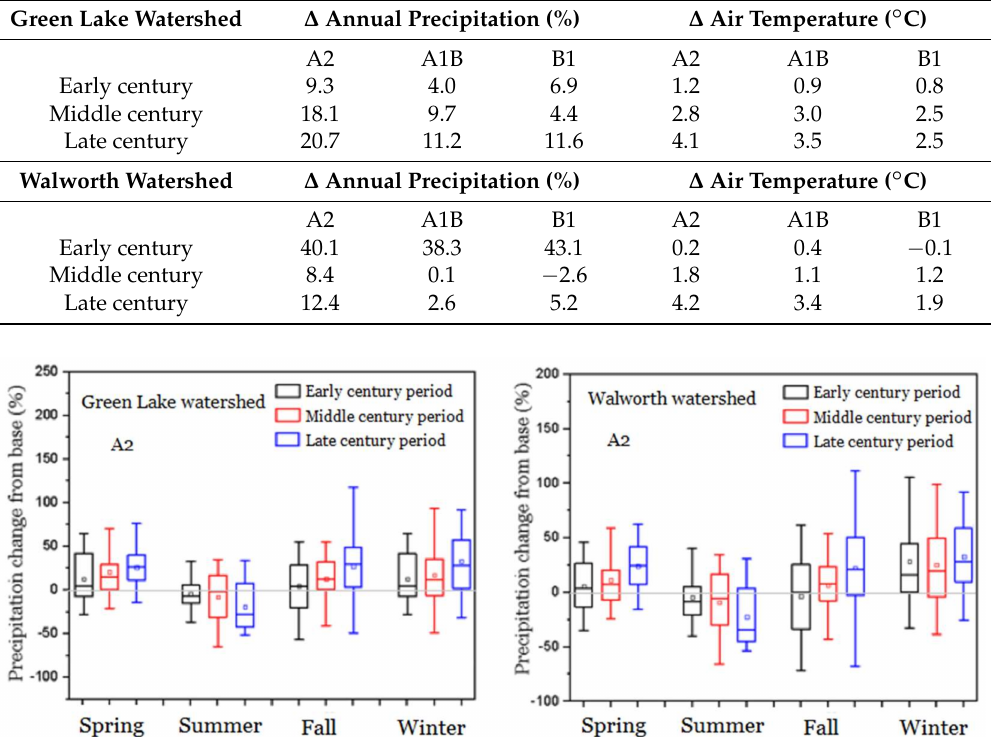
Figure 3. Seasonal precipitation changes at the Green Lake watershed and Walworth watershed under the A2 scenarios. Boxes show median with the line within the box, the average with a square within the box, and the 25th percentile and 75th percentiles with the lines at the top and bottom of the box. Percent change is relative to the base period, with positive values indicating an increase. ( left ): Green Lake watershed, ( right ): Walworth watershed.